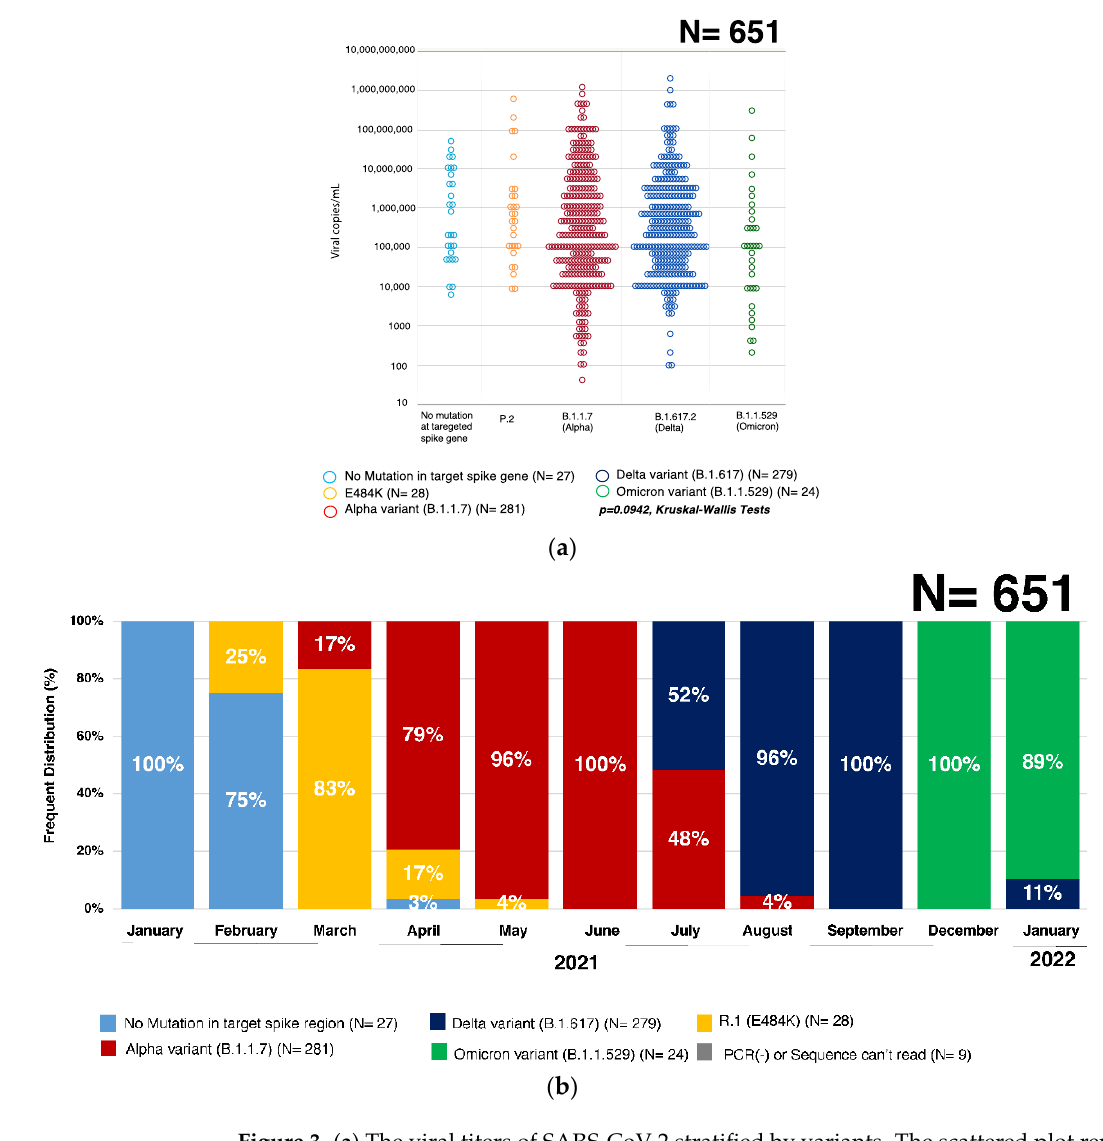
Figure 3. ( a ) The viral titers of SARS-CoV-2 stratified by variants. The scattered plot represents the viral titers detected in all samples of our study, where the blue colored dot represents those samples having no mutation at the targeted spike region, the yellow color represents PANGO Lineage R.1, the red color represents Alpha variant, the dark blue color represents Delta variant, and green represents Omicron variant. The y-axis for the viral titer is expressed in copies per milliliter. ( b ) Percent Distribution of SARS-CoV-2 variants in Hiroshima (January 2021~2022). This figure shows the percent distribution of SARS-CoV-2 variants during the study period in each month. The light blue bar represents those samples having no mutation at the target region, the yellow color represents the PANGO Lineage R.1, the red color represents the Alpha variant, the dark blue is for Delta variant, and green is for Omicron variant.